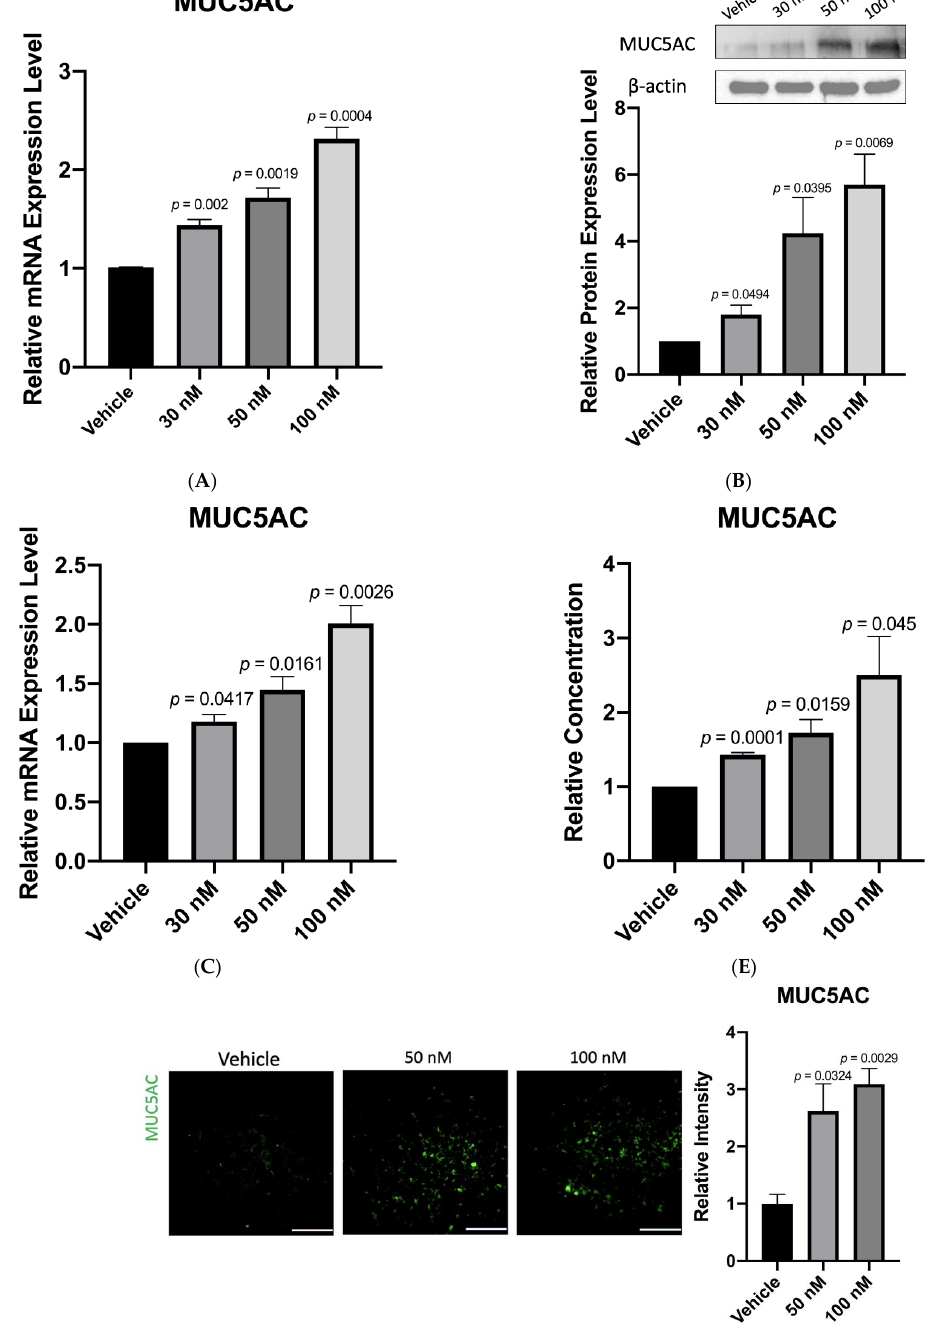
Figure 2. Anti-miR-328 treatment increases MUC5AC expression: ( A , B ) In BAC-treated rabbit goblet cells, anti-miR-328 dose-dependently increases MUC5AC RNA according to quantitative PCR and protein expression by Western blotting, n = 3 for each group. ( C ) Quantitative PCR results reveal anti-miR-328 dose-dependently increases MUC5AC RNA in rabbit goblet cells exposed to desiccation stress, n = 3 for each group. ( D ) Immunofluorescence of rabbit goblet cells reveals increased MUC5AC signals with anti-miR-328 treatment. The right panel is the quantitative data of immunofluorescence. Magnification: 100×. Scale bar = 200 µm, n = 3 for each group. ( E ) ELISA results reveal a dose-dependent increase in MUC5AC secretion with anti-miR-328 treatment in the culture medium of BAC-treated goblet cells. n = 3 for each group.